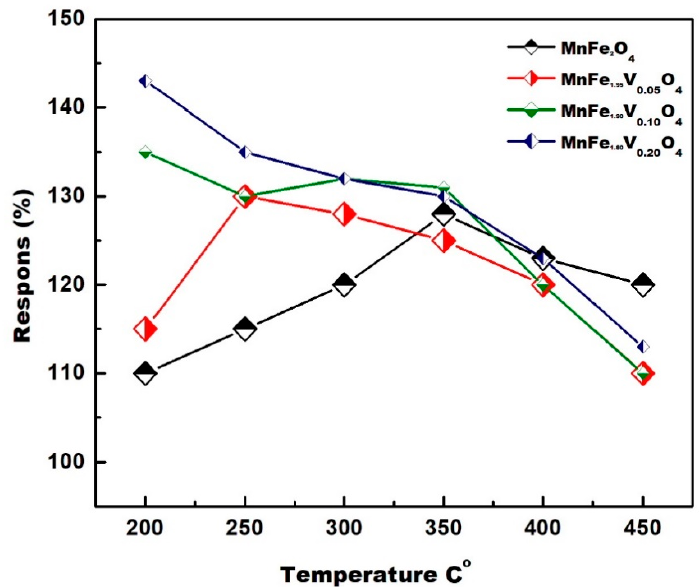
Figure 9. Variation in sensor response with operating temperature; MnV x Fe 1–x O 4 (x = 0.05, 0.1, and 0.2).